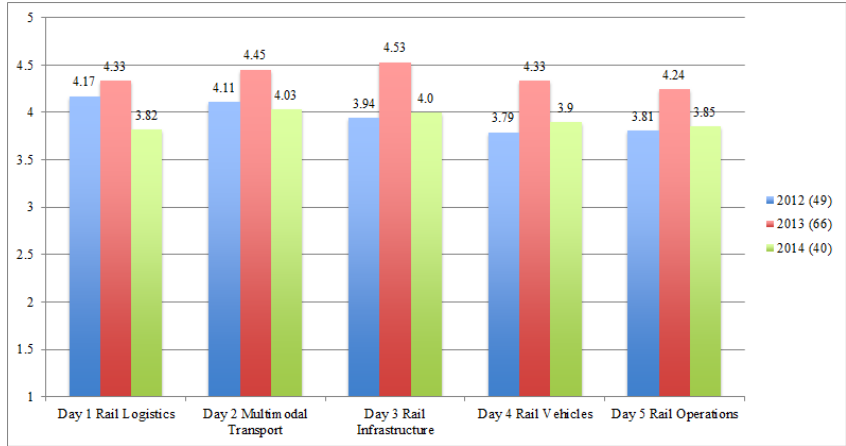
Figure 1. Mean ratings for lecture days in Week